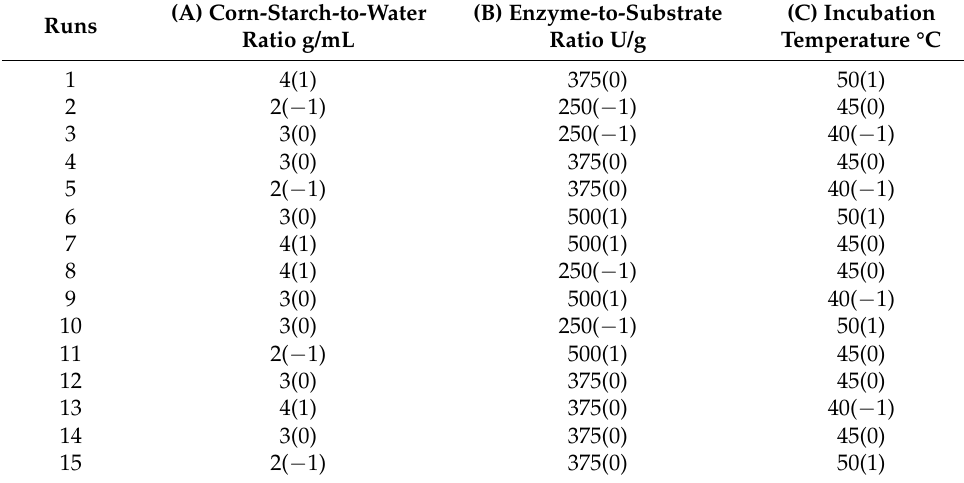
Table 2. BBD of the different formulations for the enzymatic hydrolysis conditions.